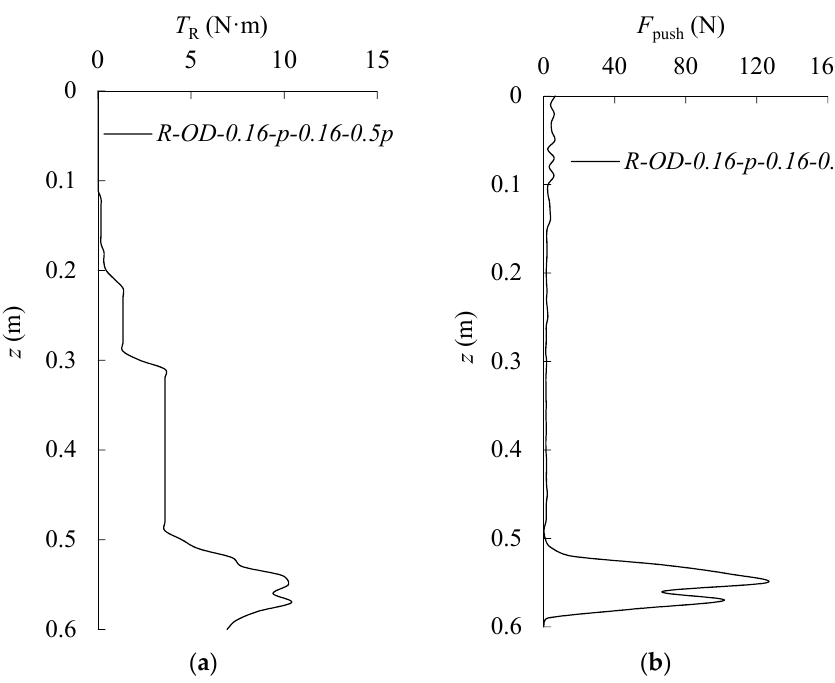
Figure 12. The test results of TN-7. ( a ) Recycling torque. ( b ) Vertical force on shaft.